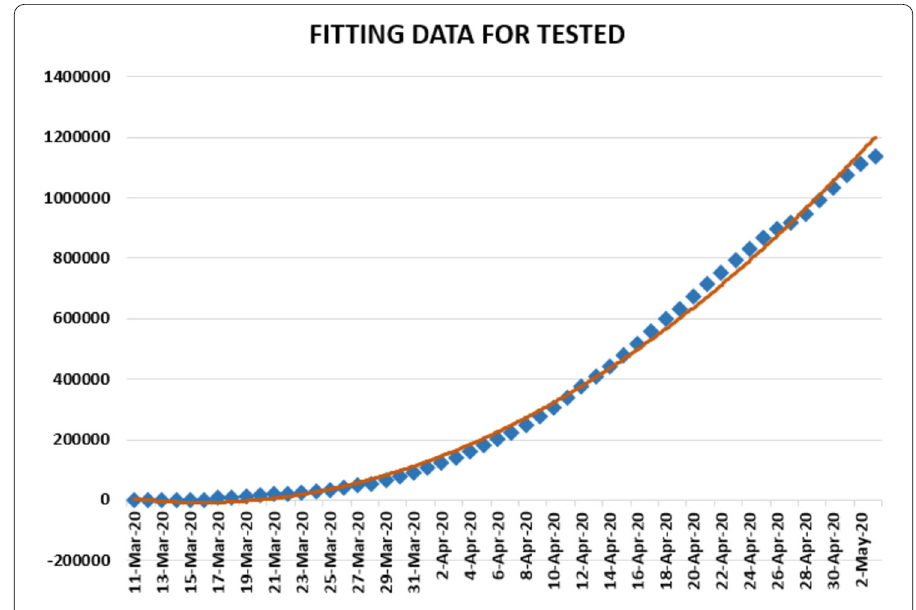
Figure 16 Polynomial fitting for tested people in Turkey from 11 March 2020 to 3 May 2020